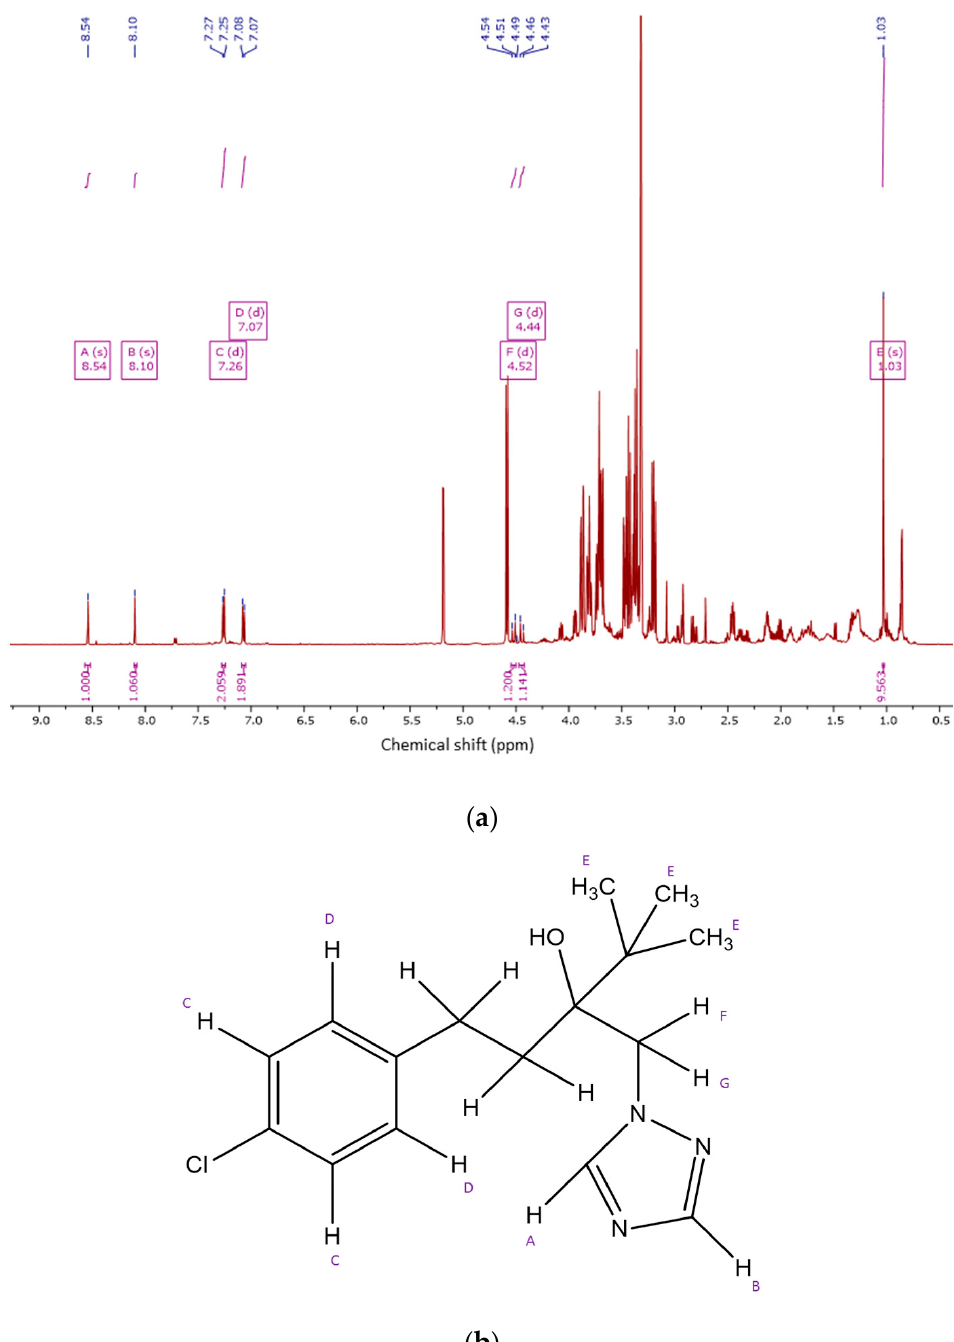
Figure 3. 1 HNMR spectra C. roseus seedlings treated with 0.03% Pronto Plus ( a ) and tebuconazole structure ( b ).